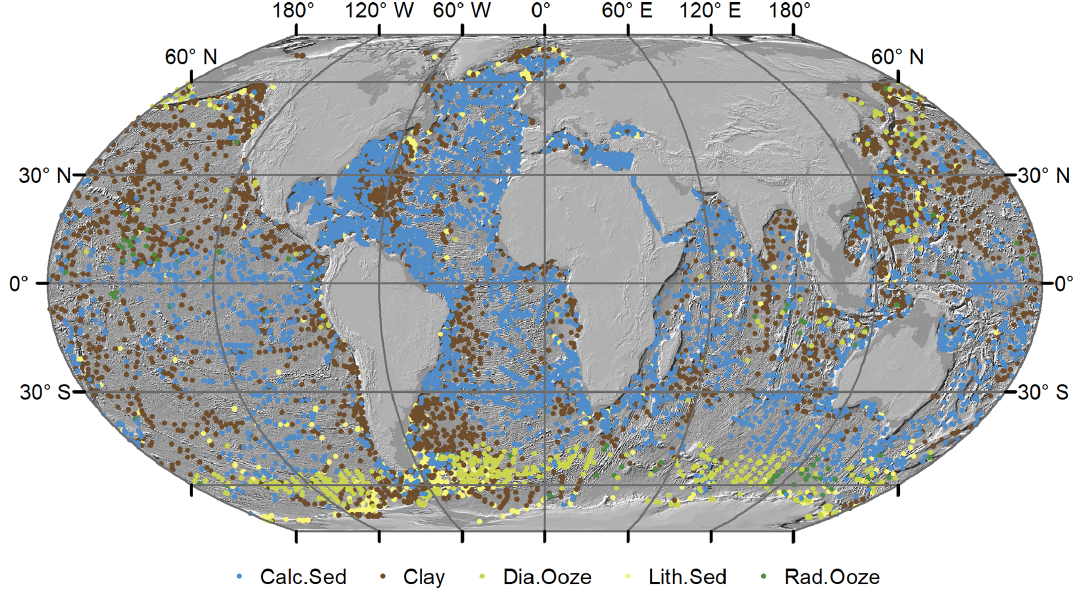
Figure 1. Locations of samples used in this study based on data from Dutkiewicz et al. (2015). Land masses are derived from ESRI (2010). Hillshade topography is derived from GEBCO